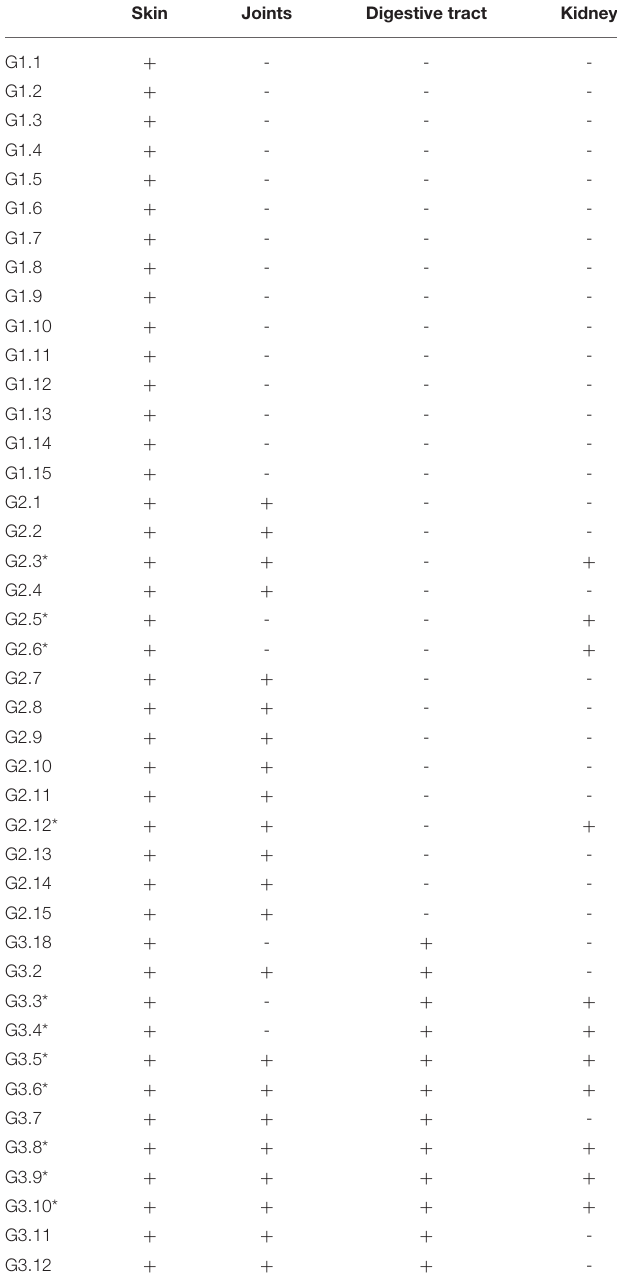
* Children with IgA vasculitis involving kidney damage. “ + ” represents the presence of symptoms involving the organ, and “ − ” represents no symptoms which affect the organ.